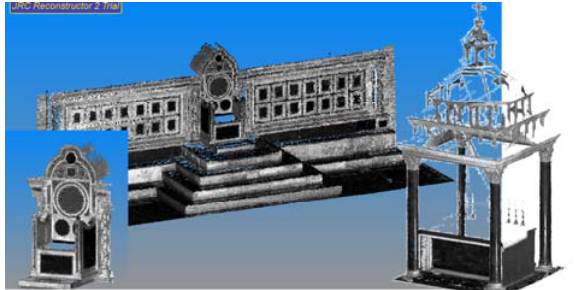
Figure 6. The visualitazion of the model elaborated with Reconstructor